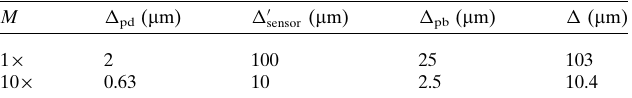
Table 1 Calculated spatial resolution of the entire optical system, (cid:2) , for M = 1 and M =